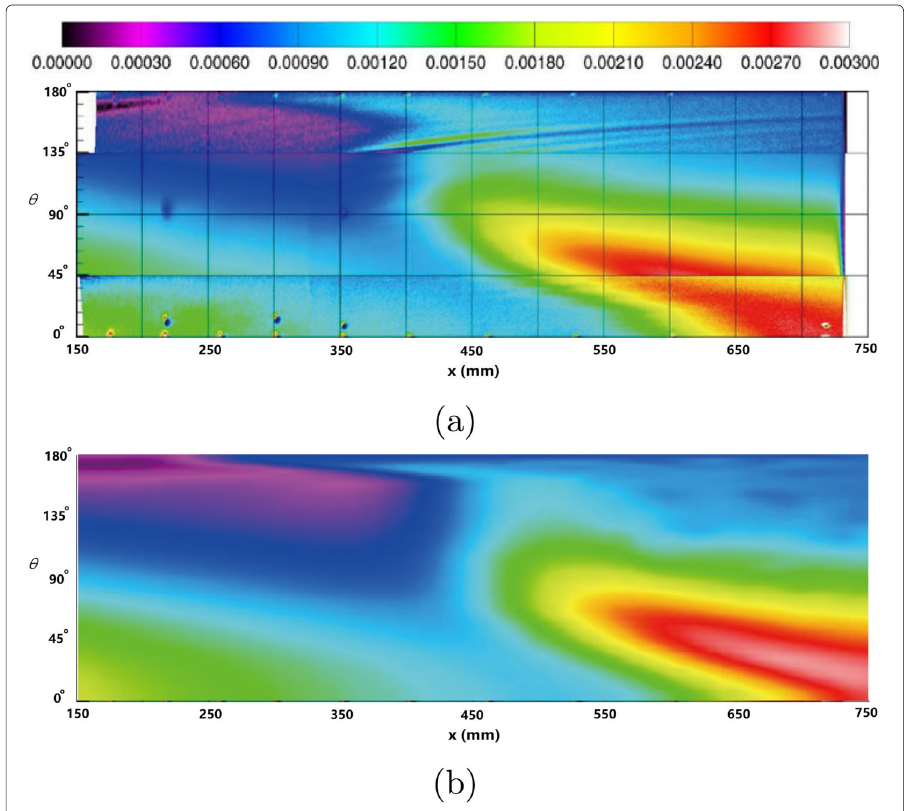
Fig. 3 The St contours a measured by Willems et al. [22] and b computed by the SED-SL model for the GAC-6 case